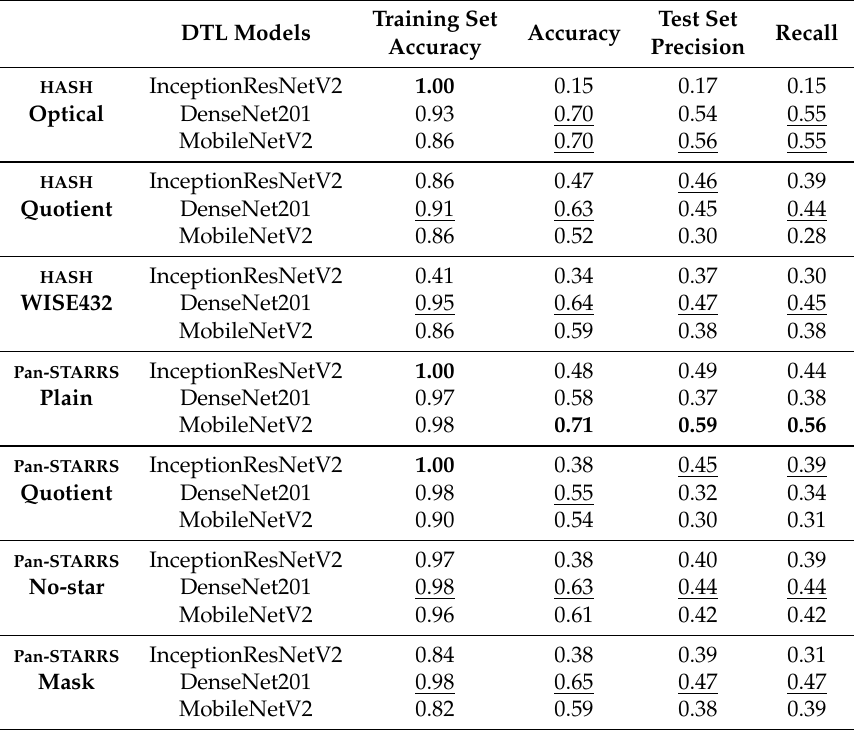
Table 8. Average accuracy, precision and recall for planetary nebulae morphology classification using image resources from HASH DB and